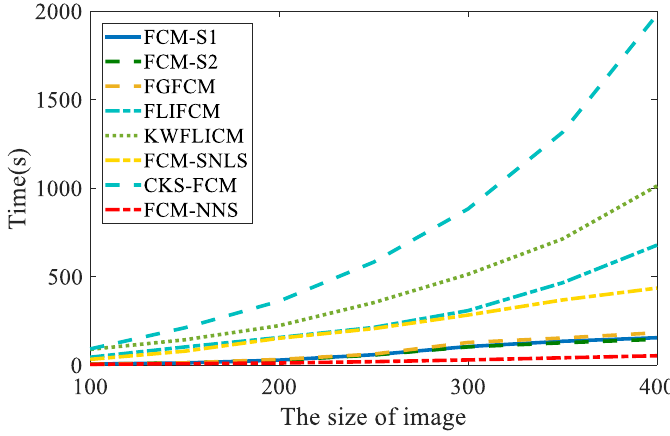
Figure 16. Running time of the eight algorithms.